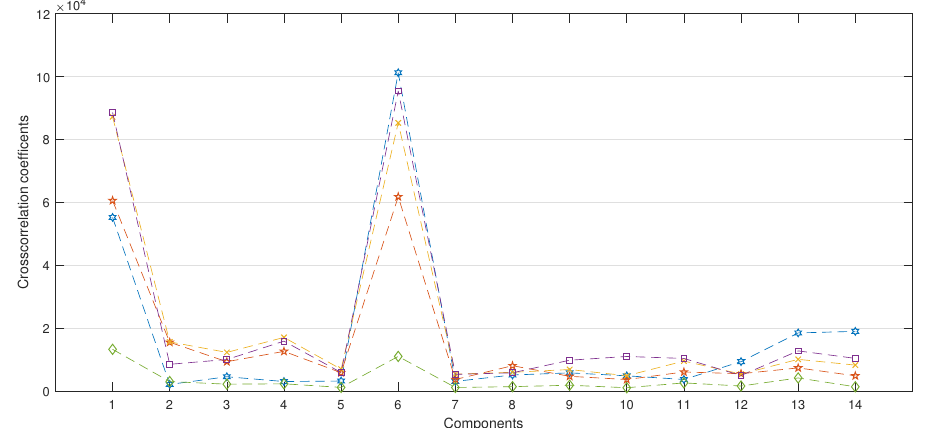
Figure 3. Illustration of the cross-correlation coefficients obtained between every IC and EOG in all trials for subject S 12 (negative values are